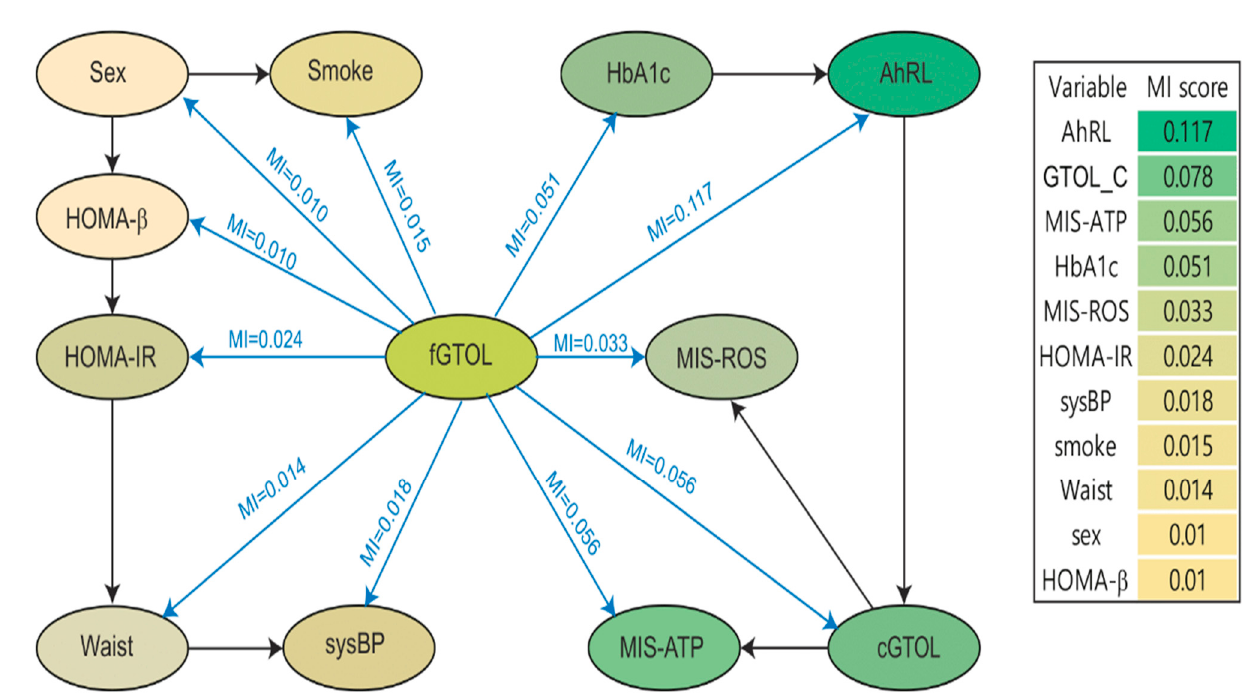
Figure 3. Structure of BN prediction model and mutual information (MI) between the target and each predictor node. Variables connected by edges are conditionally dependent on each other. The scores for MI between the target node fGTOL and the predictor nodes are presented on each blue edge. The variable nodes are color coded according to their MI scores. Variables in the box were sorted in descending order of MI scores.